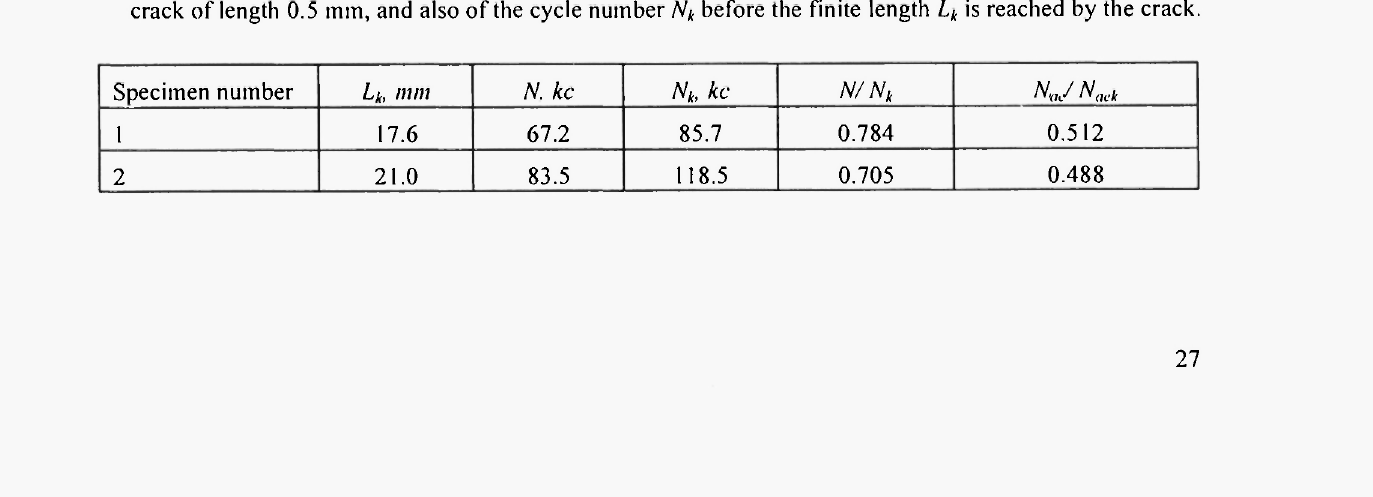
Fig. 3: Diagram of the relative total AE dependence on the relative number of variable load cycles (specimen